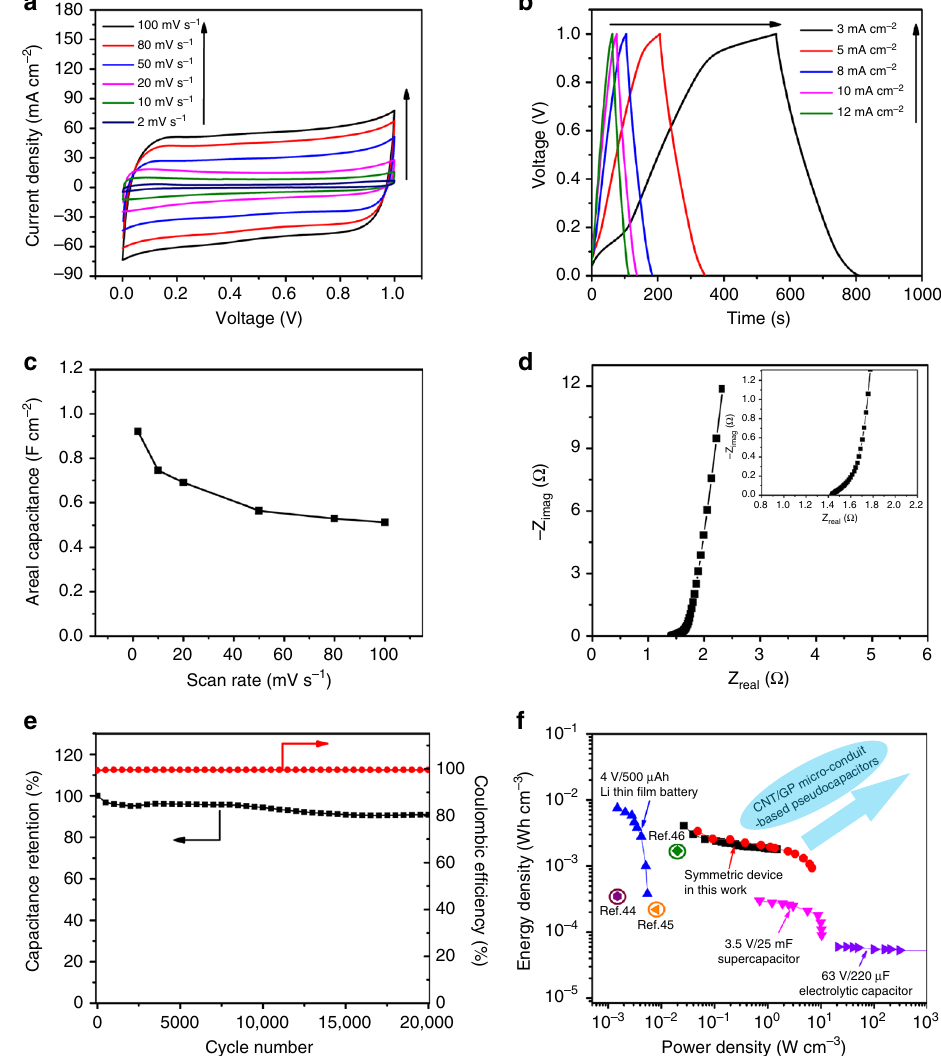
Fig. 4 Electrochemical performance of two-terminal symmetric supercapacitor devices. a CV curves of the symmetric supercapacitor device at scan rates from 2 to 100 mV s − 1 with a voltage range between 0 and 1 V in 1 M H 2 SO 4 . b Galvanostatic charge/discharge curves of the present device at low current densities from 3 to 12 mA cm − 2 in the voltage range between 0 and 1 V. c Capacitance of the device as a function of scan rate. d Nyquist plot for the present symmetric device recorded from 0.1 Hz to 1 MHz with an AC perturbation amplitude of 5 mV. e Cyclic stability and coulombic ef fi ciencies of the